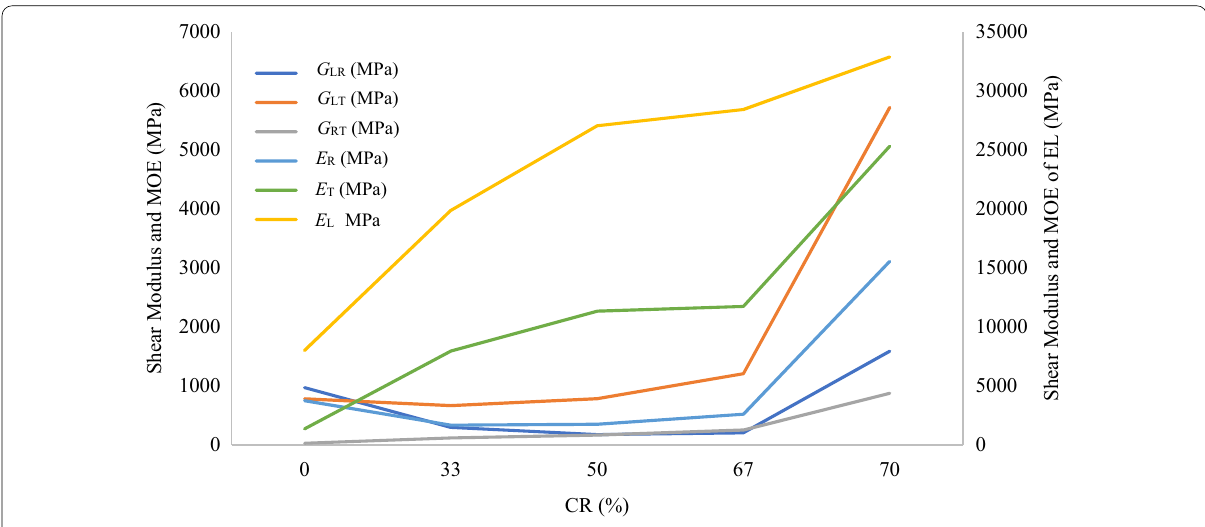
Fig. 7 Results from [30] comparing the MOE and Shear Modulus of different directions and